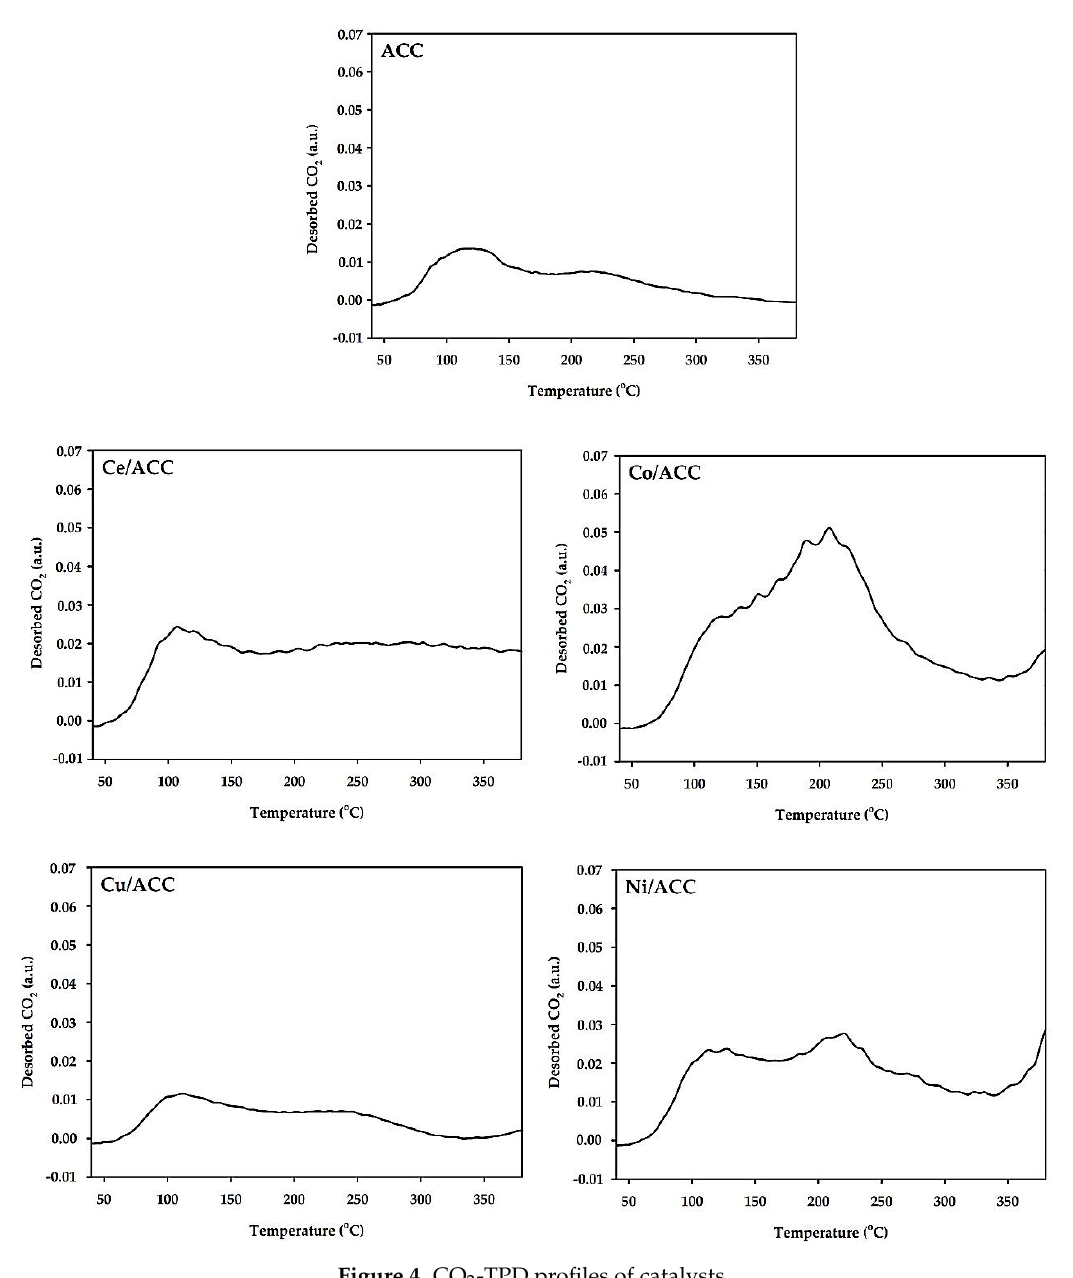
Figure 4. CO 2 -TPD profiles of catalysts.